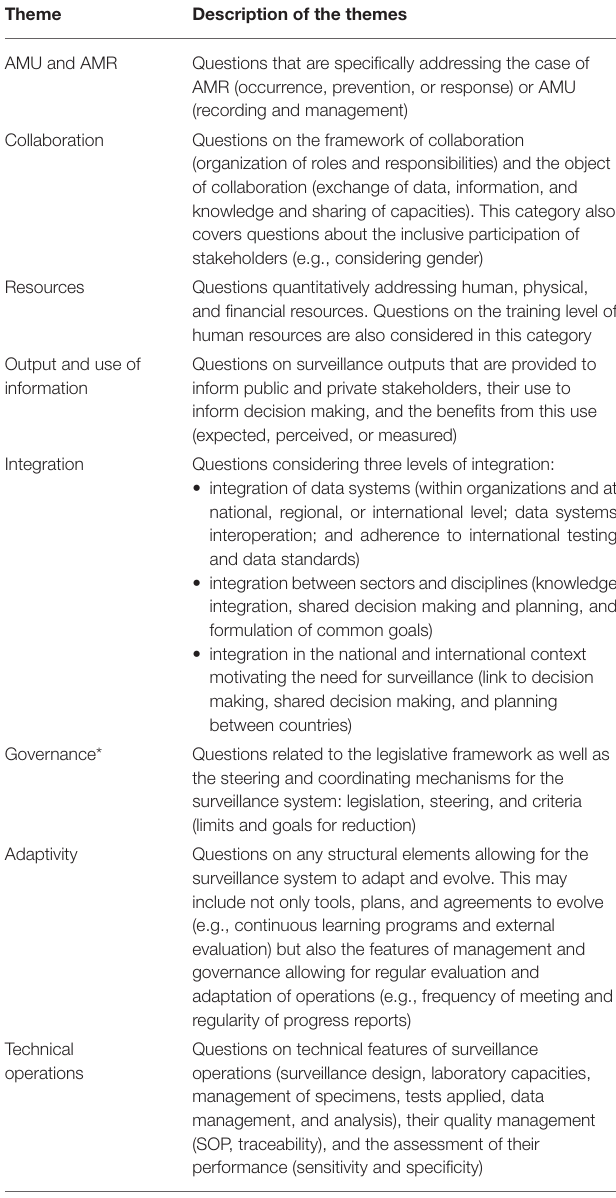
TABLE 2 | Description of the themes describing the scope of the tool in relation to surveillance identified in the Co-Eval-AMR project and used for the additional assessment of the evaluation tools for surveillance